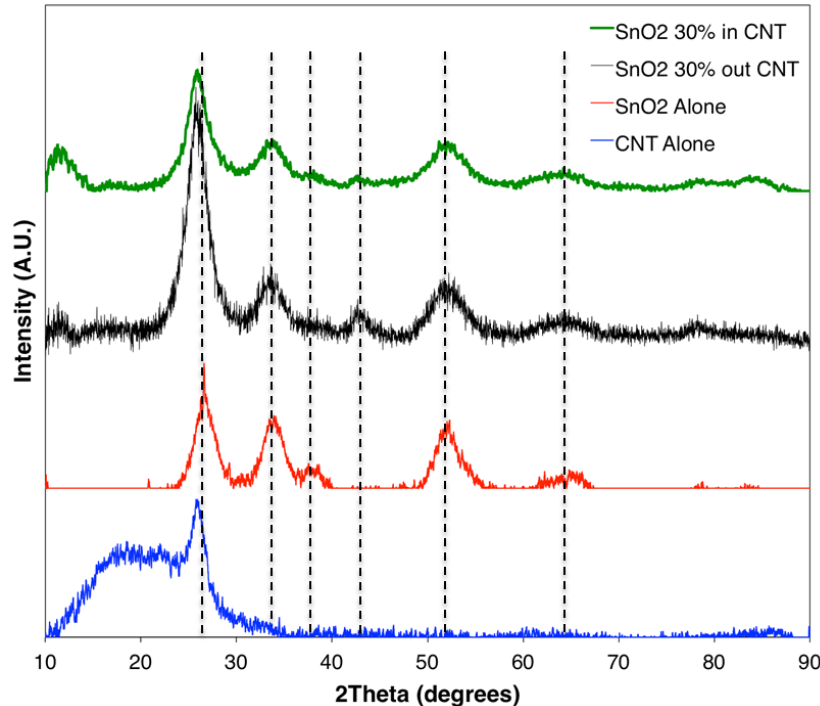
Figure 2. XRD plots for samples with confined and unconfined SnO 2 in/on a CNT, and also patterns for pure SnO 2 and a CNT.